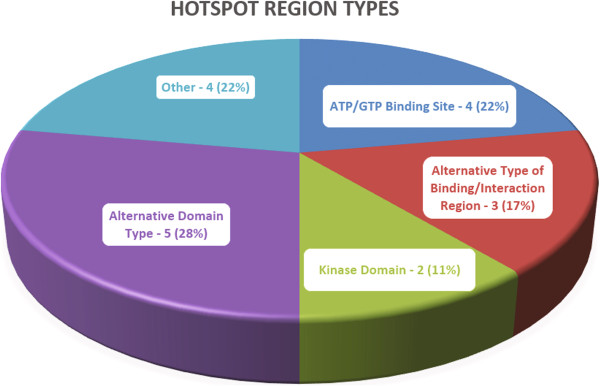
Results summary. A breakout of what biologically relevant regions are overlapped by the most significant cluster for each of the 18 proteins. Overall, 77% of the hotspots overlap a binding site or a protein domain.